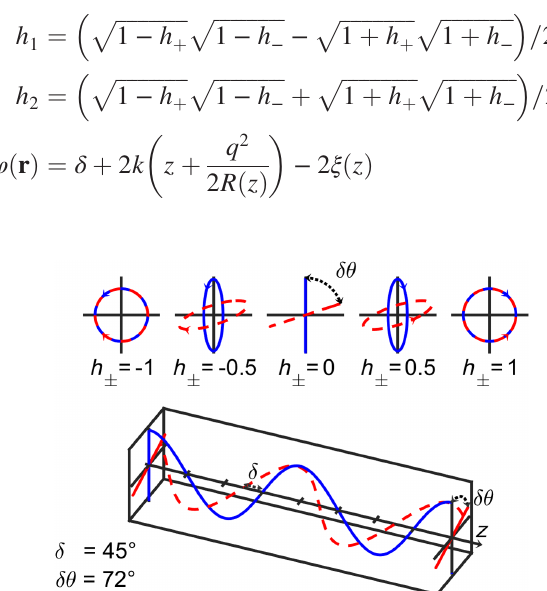
FIG. 2. The polarization vectors e (cid:1) for each of the two counterpropagating Gaussian beams are represented for plane- wave electric fields. In blue, a beam with e þ and k > 0 and in red, with e − and k < 0 . The schematics illustrates the effects of the phase δ and the polarization main axis angle δθ on beams linearly polarized with h (cid:1) ¼ 0 . The insets show the polarization ellipses for different values of h (cid:1) . The effect of the δθ parameter is seen when the beams are not circularly